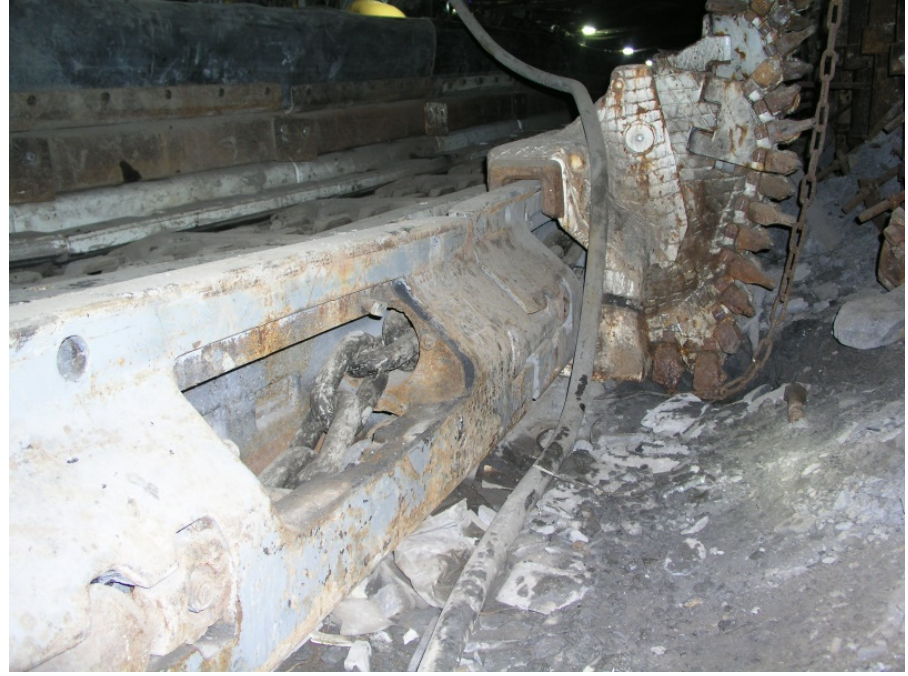
Figure 2. Subject of measurements: coal plough system at LW Bogdanka.